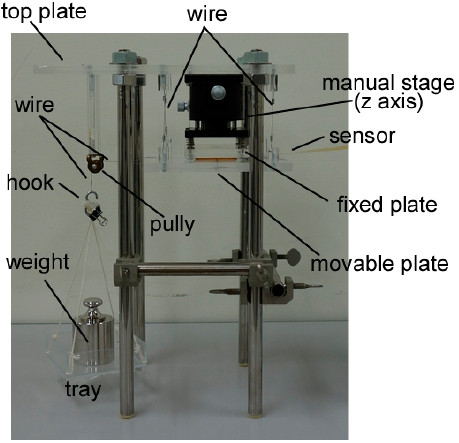
Figure 4. Testing apparatus to obtain sensor output vs. shear load.